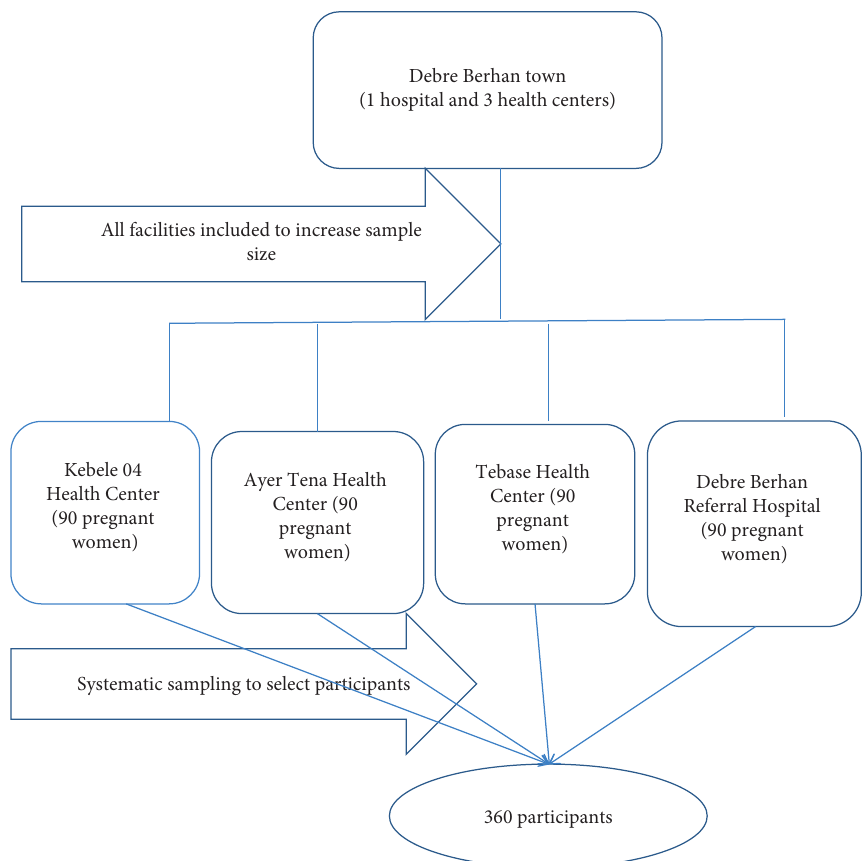
Figure 1: Schematic representation of sampling procedure for assessing PMTCT service utilization in Debre Berhan Town, June,